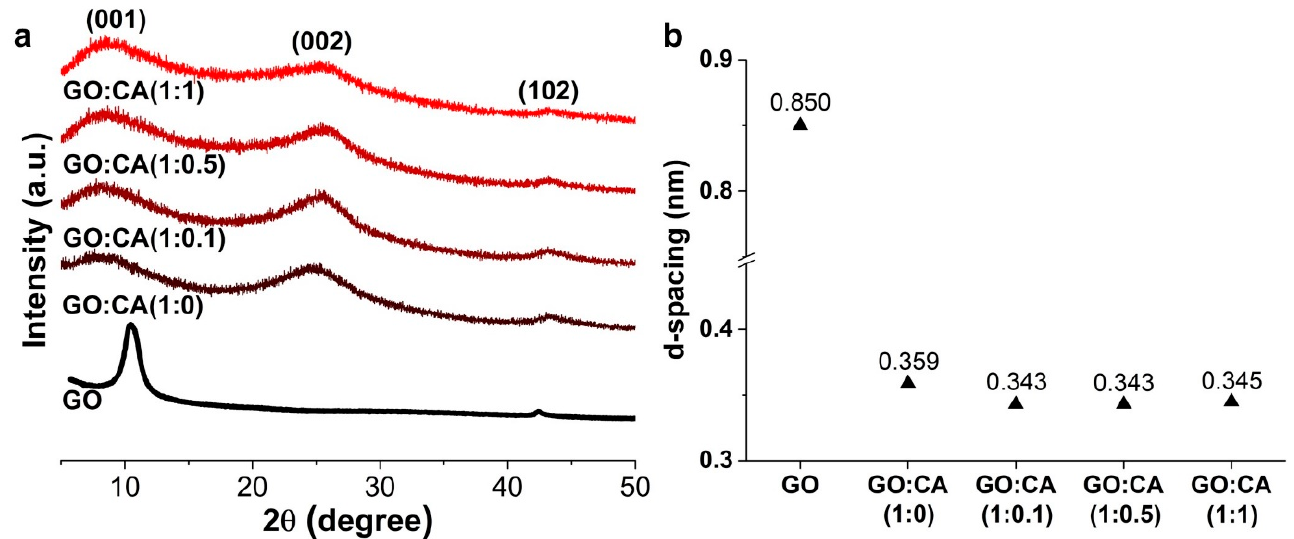
Figure 4. ( a ) XRD diffraction patterns and ( b ) the corresponding d -spacing value of GO and reduced samples: GO:CA (1:0); GO:CA (1:0.1); GO:CA (1:0.5) and GO:CA (1:1).